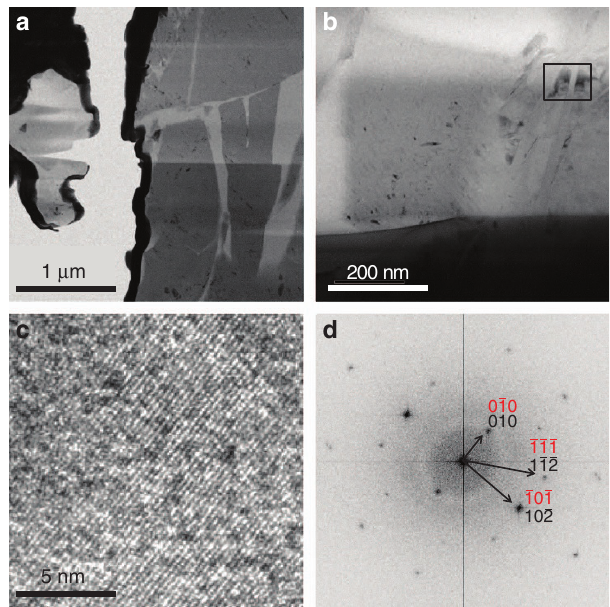
Figure 7 | TEM analyses of the recovered samples. Powder sample recovered from an experiment where starting a -cristobalite was cold-pressed to ca. 50GPa and quenched to ambient conditions. ( a , b ) Bright field image showing isolated crystalline grains (dark grey) surrounded by amorphous matrix (light grey), with the rectangle in b marking the area selected for the HRTEM image shown in c . FFT (Fast Fourier Transform) diffraction pattern ( d ) derived from the area presented in c . The d -spacings obtained by FFT can be indexed as both a -cristobalite (black) and seifertite (red) in this particular direction. Due to high beam sensitivity, only one orientation of the specimen was acquired. The pattern seems to be more suitably indexed as a